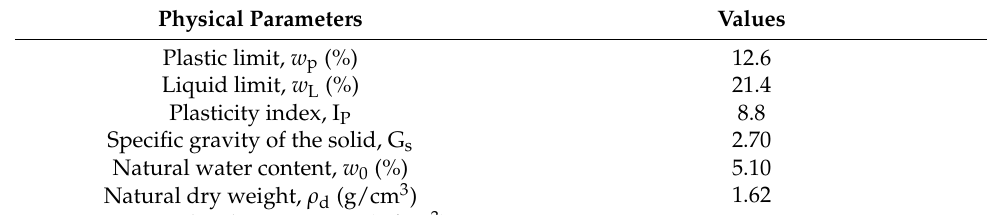
Table 1. Basic physical properties of silt.